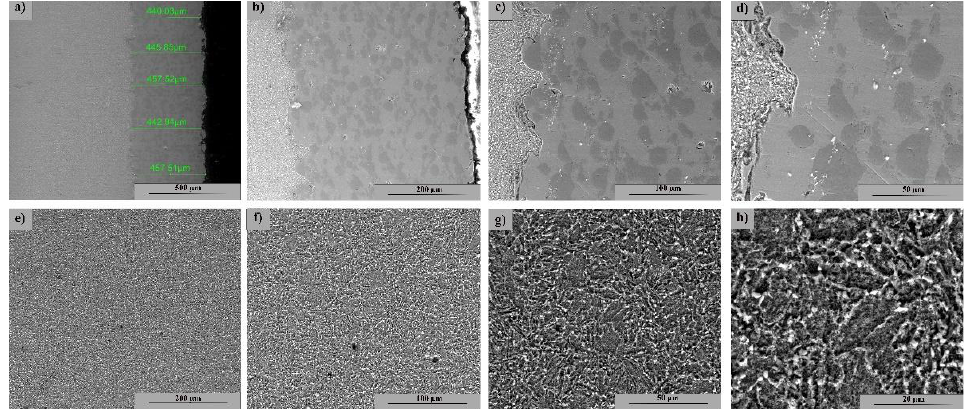
Figure 2. SEM image of the cross-section at the interface between the base and the coated materials: ( a – d ): Cold spray Ni/CrC layer — ( a ) 200×; ( b ) 500×; ( c ) 1000×; ( d ) 2000×; ( e – h ): 4340 microstructure base material — ( e ) 500×; ( f ) 1000×; ( g ) 2000×; ( h ) 5000×.